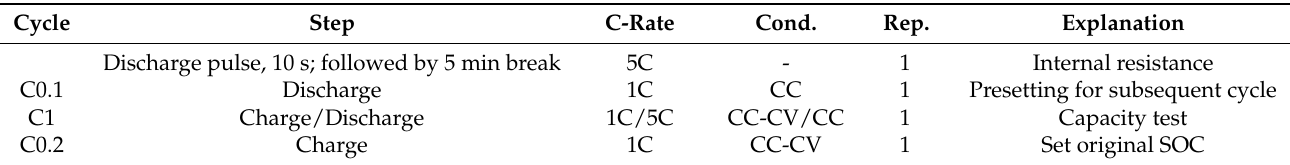
Table 1. The testing protocol of the short quality test.